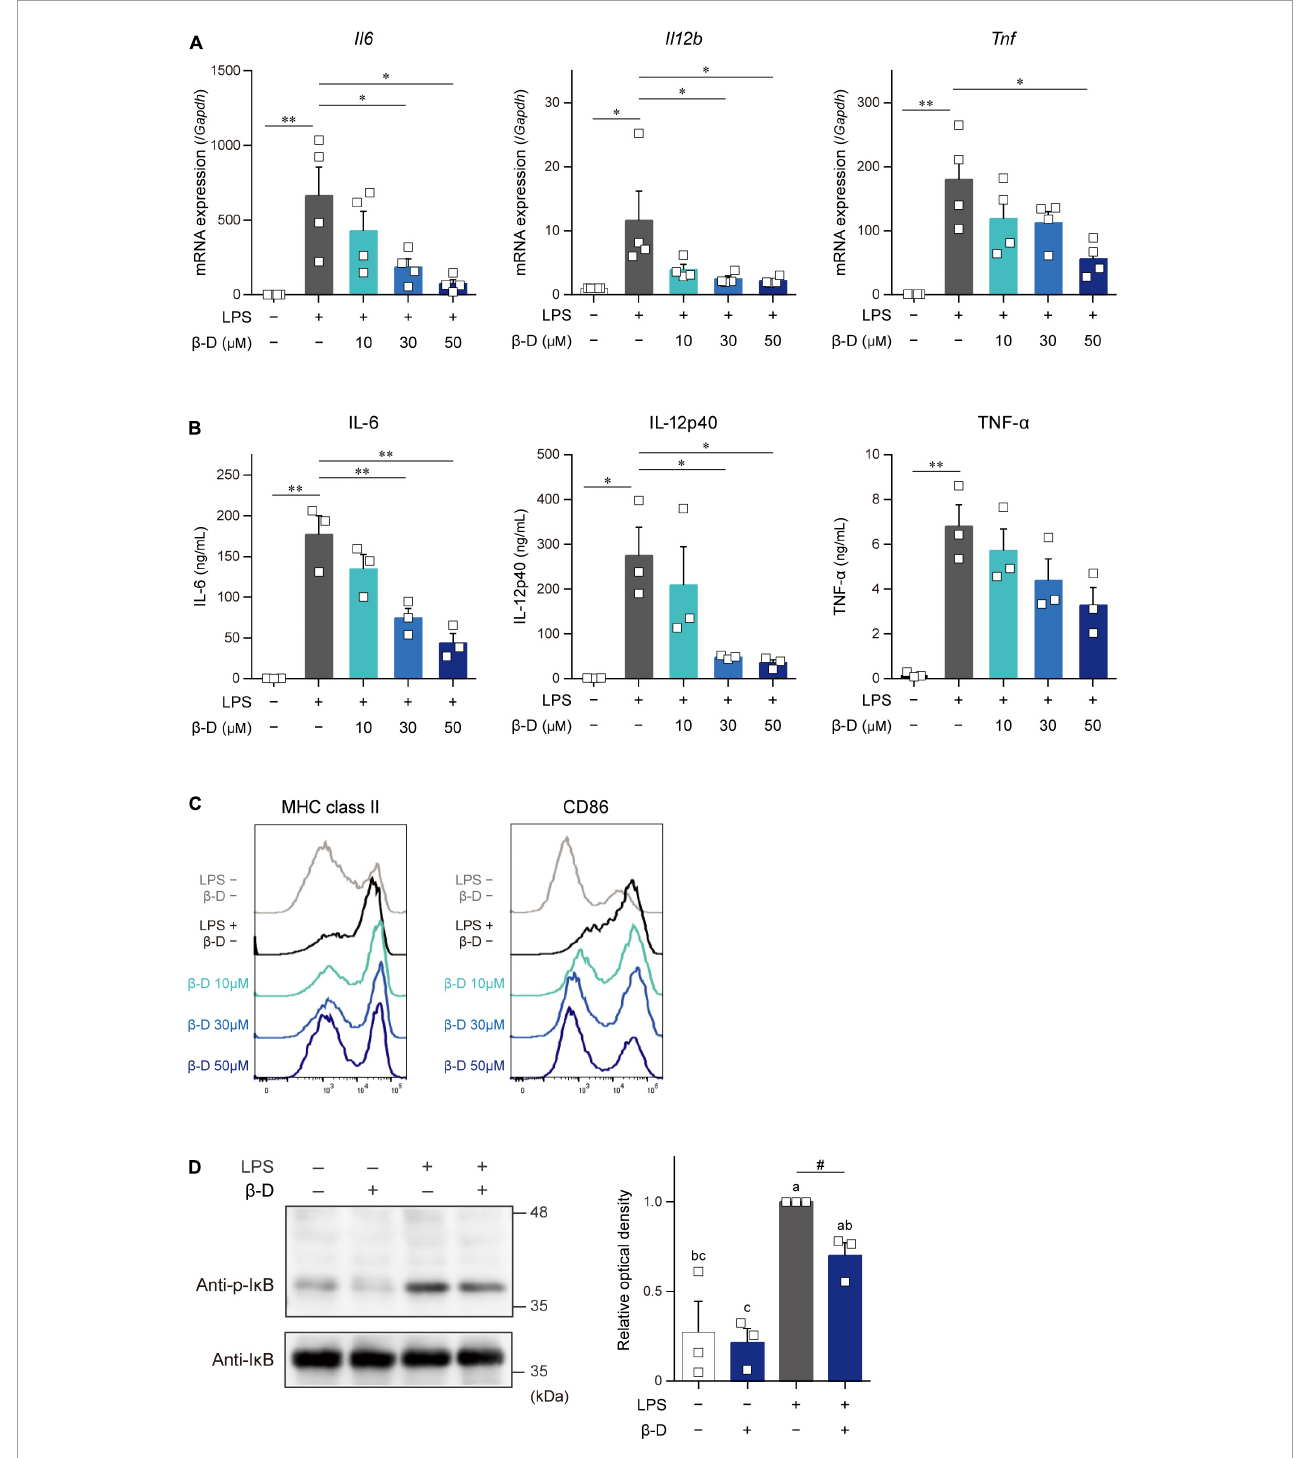
FIGURE2 β -Damascone suppressed the LPS-induced activation of DCs. (A) Messenger RNA expression levels in BMDCs. (B) Cytokine concentrations in the culture media of BMDCs. (C) Cell surface expression levels of MHC class II and CD86 on BMDCs. (D) Western blot profiles of phosphorylated I κ B and total I κ B. BMDCs pretreated with indicated concentrations of β -damascone for 24 h were stimulated with 100 ng/ml LPS. Cells were harvested 3 and 24 h after the LPS stimulation to measure mRNA levels (A) and cell surface protein expression levels (C) , respectively, and culture media were collected at 24 h after the stimulation to assess cytokine concentrations (B) . In the Western blot analysis, cells were lysed 1 h after the LPS stimulation, and aliquots of whole cell lysate containing 10 µ g of protein were added to each lane ( D , left). Data of three independent experiments were quantified by calculating the band intensity, and shown as ratio to that of (p-I κ B) / (total I κ B) in LPS-stimulated DCs without β -damascone treatment ( D , right). A gating strategy of the flow cytometric analysis of BMDCs is shown in Supplementary Figure 4 . Data represent the mean ± SEM of three independent experiments performed in triplicate (A,B) . The Tukey-Kramer test was used, and significant difference was shown with ∗ p < 0.05, ∗∗ p < 0.01, in panels (A,B) . Means indicated by different small letters are significantly different based on Tukey-Kramer test and p < 0.05 on t -test were marked with # in panel (D)